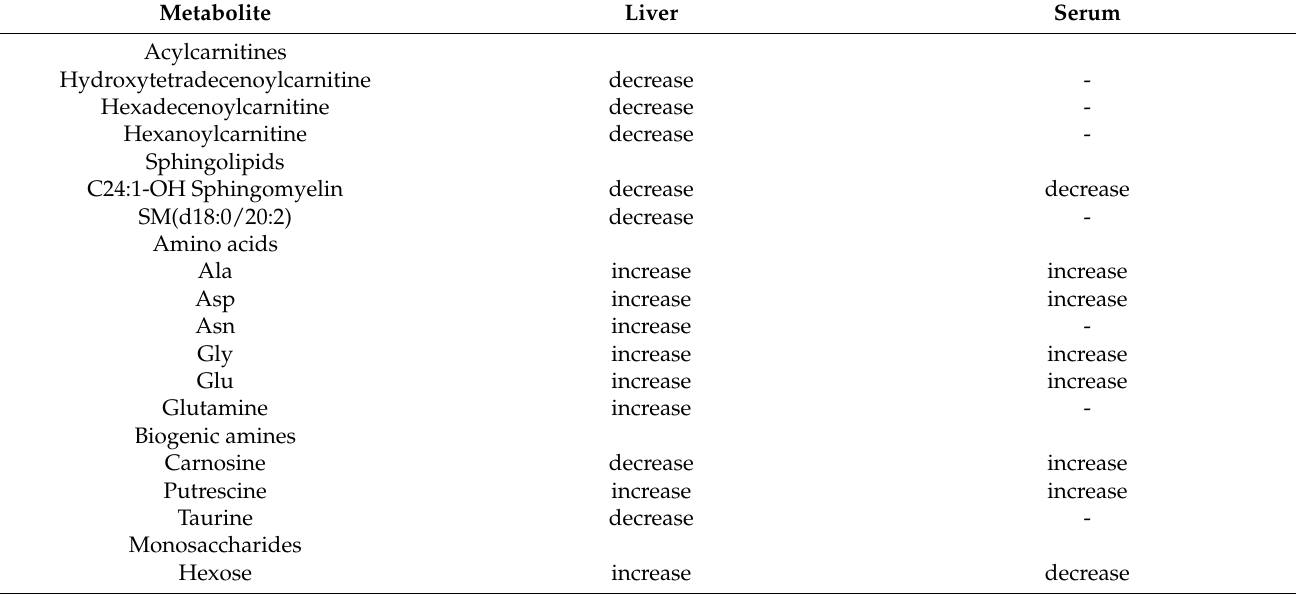
Table 2. Comparison of altered proteins due to mitochondrial treatment in the liver and in the serum (“increase” or “decrease” in the treated AD vs. the AD